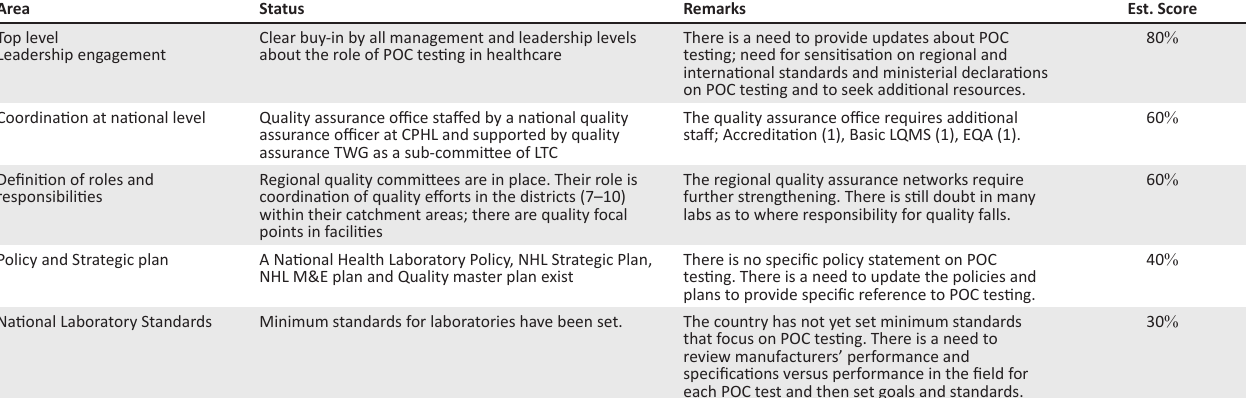
TABLE 2: Status of point-of-care quality assurance policy and framework in Uganda Area